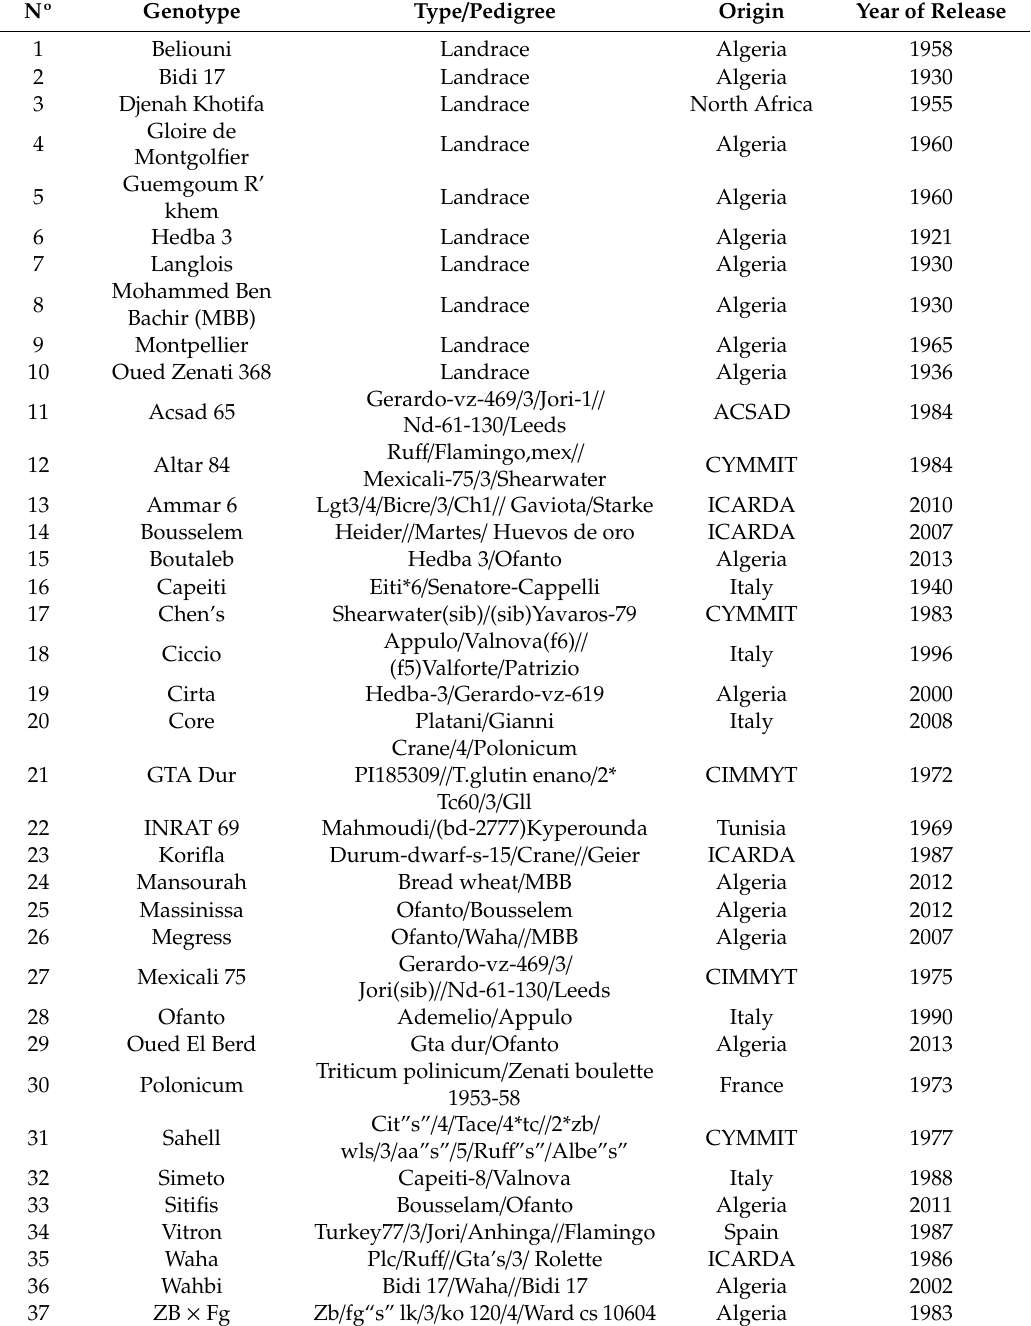
Table 1. Name, type of cultivar, origin, and year of release of 37 genotypes of durum wheat used in the